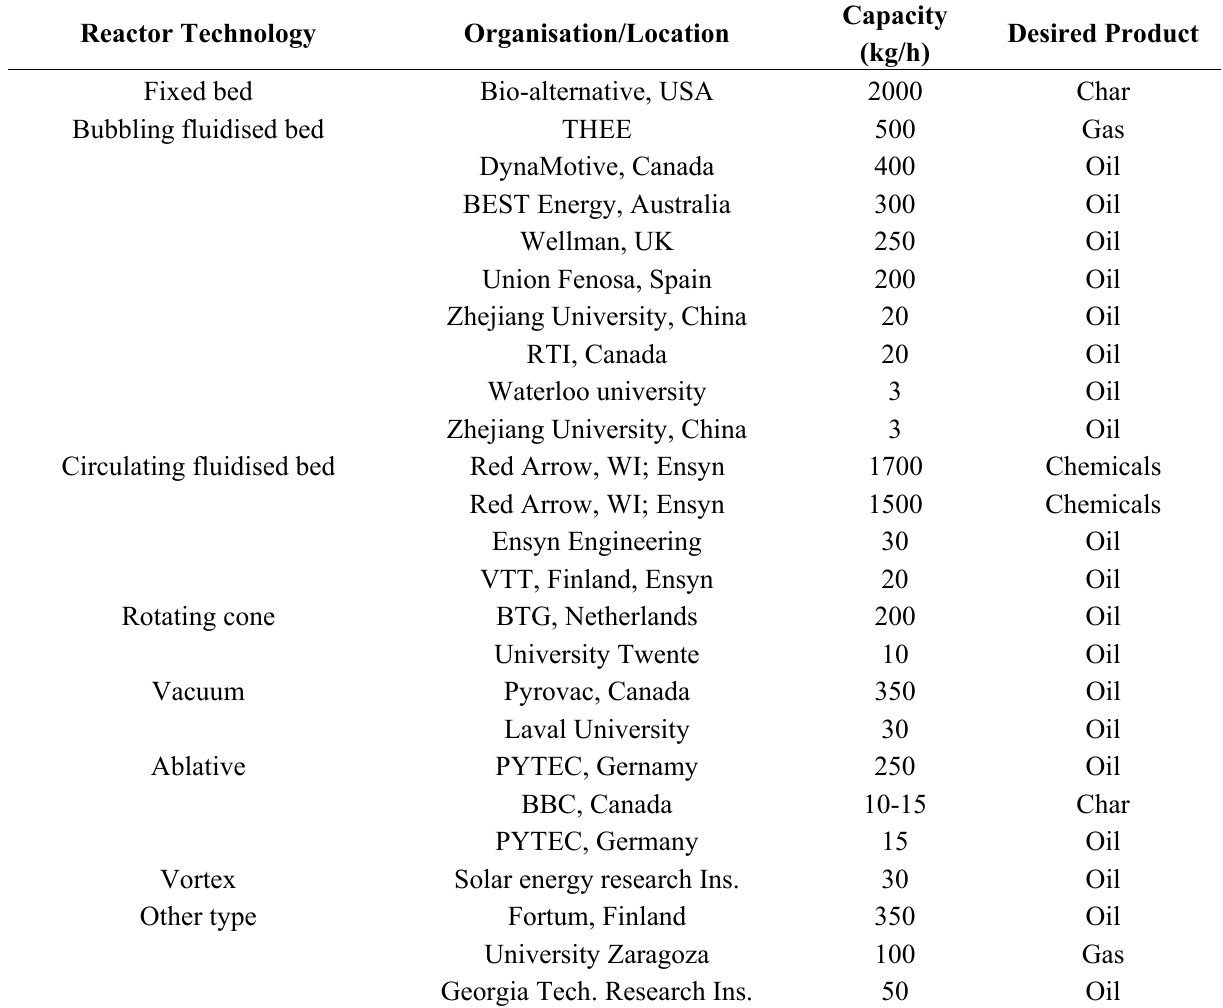
Table 13. Worldwide current pyrolysis operating plants